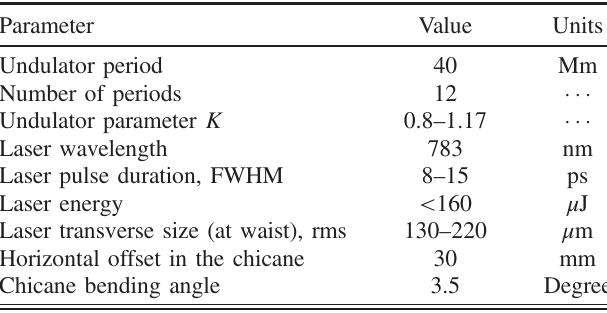
TABLE I. FERMI laser heater parameters.